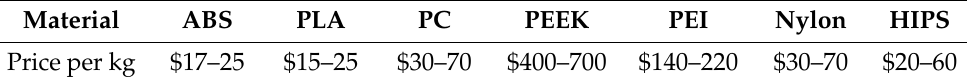
Table 2. A price list of pure thermoplastic filaments. ABS—acrylonitrile butadiene